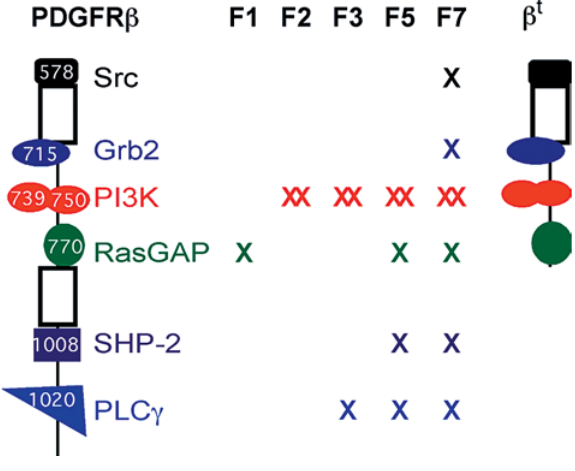
Figure 1. PDGFR b Allelic Series This figure depicts the mutant alleles generated in the mouse PDGFR b genomic locus. X represents a mutation in the tyrosine- binding site(s) for a particular signal transduction molecule. The F7 allele contains a disruption in one SFK-binding site because loss of both sites results in diminished kinase activity (Mori et al. 1993). The truncation allele ( b T ) was created by deletion and subsequent frameshift that results in a stop codon 32 amino acids past the RasGAP-binding